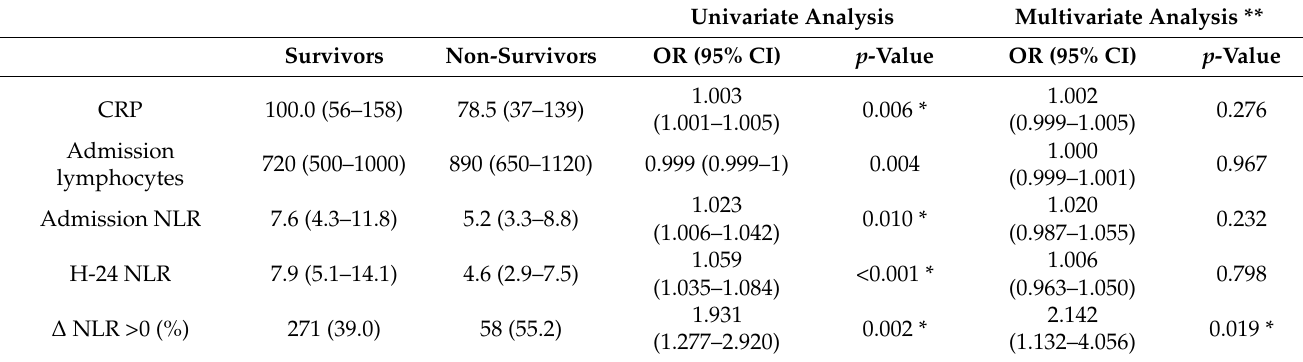
Figure 2. Receiver operating characteristics (ROC) curve for NLR as a predictive factor of severe COVID-19. Table 3. Biochemical and predictive factors of mortality in COVID-19